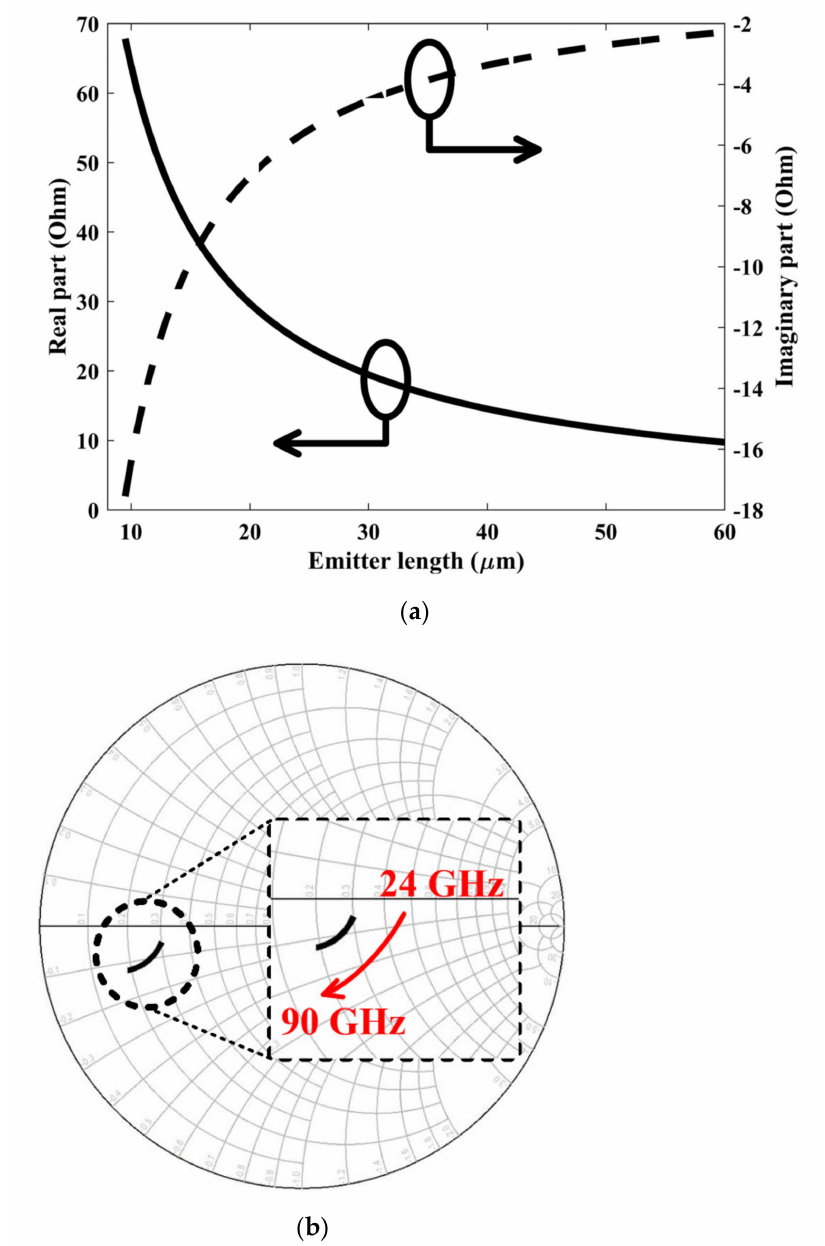
Figure 7. ( a ) Simulated real part and imaginary part of the input impedance of the switching core versus emitter length, and ( b ) the input impedance of the switching core versus RF frequency in Smith